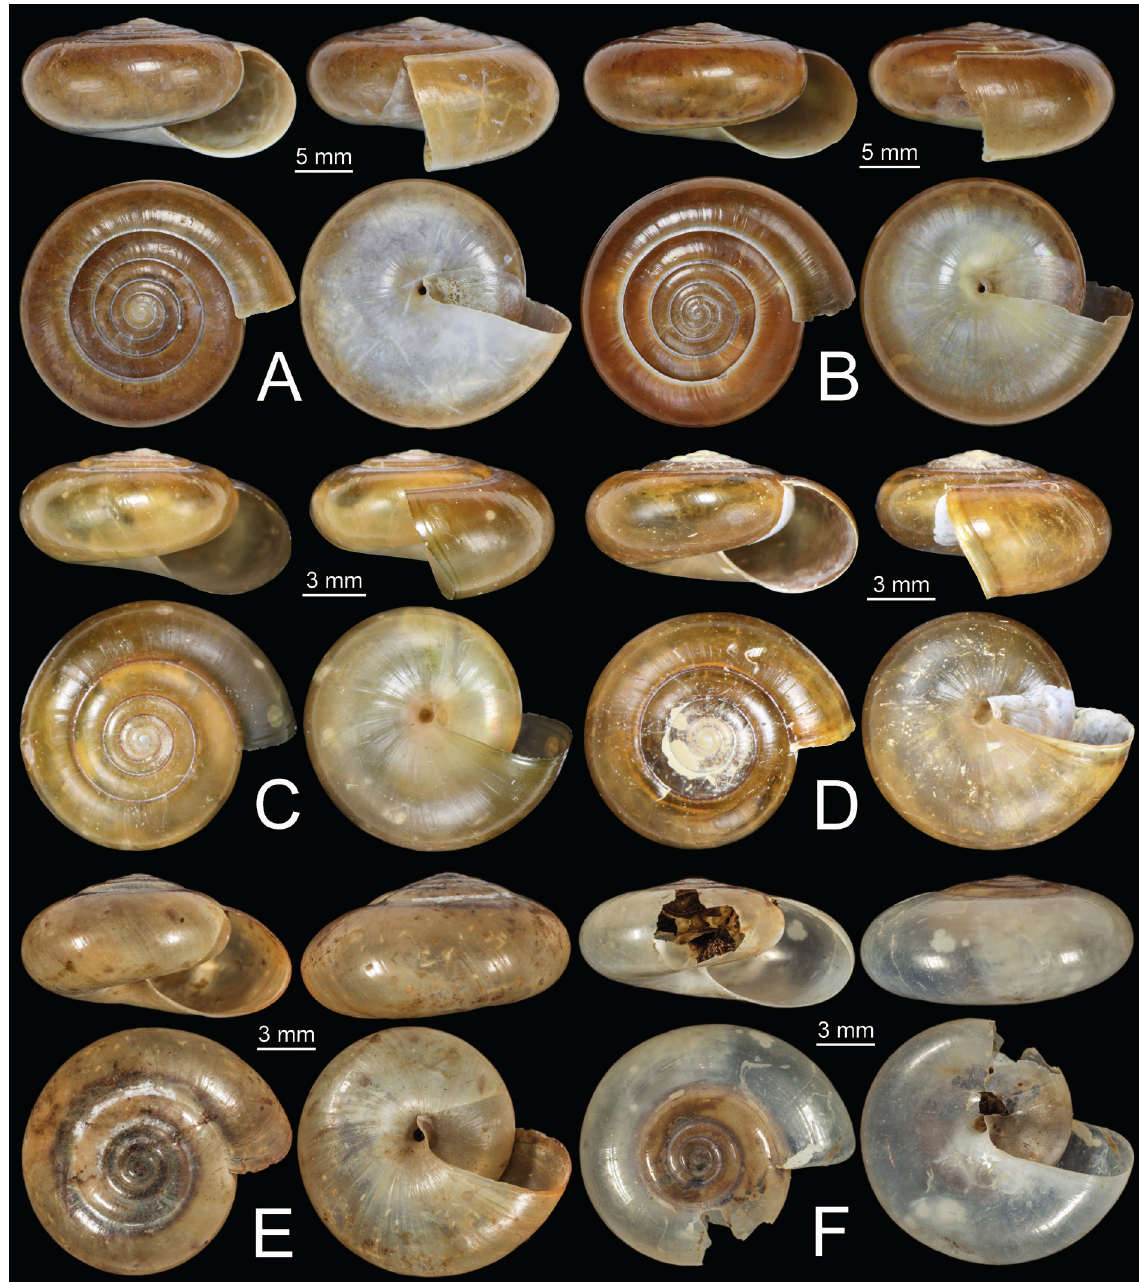
Fig. 4. Shells of Sarika spp. A . Sarika khmeriana Pholyotha & Panha sp. nov., holotype (CUMZ 7904). B . Sarika khmeriana Pholyotha & Panha sp. nov., paratype (CUMZ 7905). C . S. nana Pholyotha & Panha sp. nov., holotype (CUMZ 7907). D . S. nana Pholyotha & Panha sp. nov., paratype (CUMZ 7908). E . Macrochlamys excepta (Mabille, 1887), syntype (MNHN-IM-2000-27886). F . M. zero (Mabille, 1887), syntype